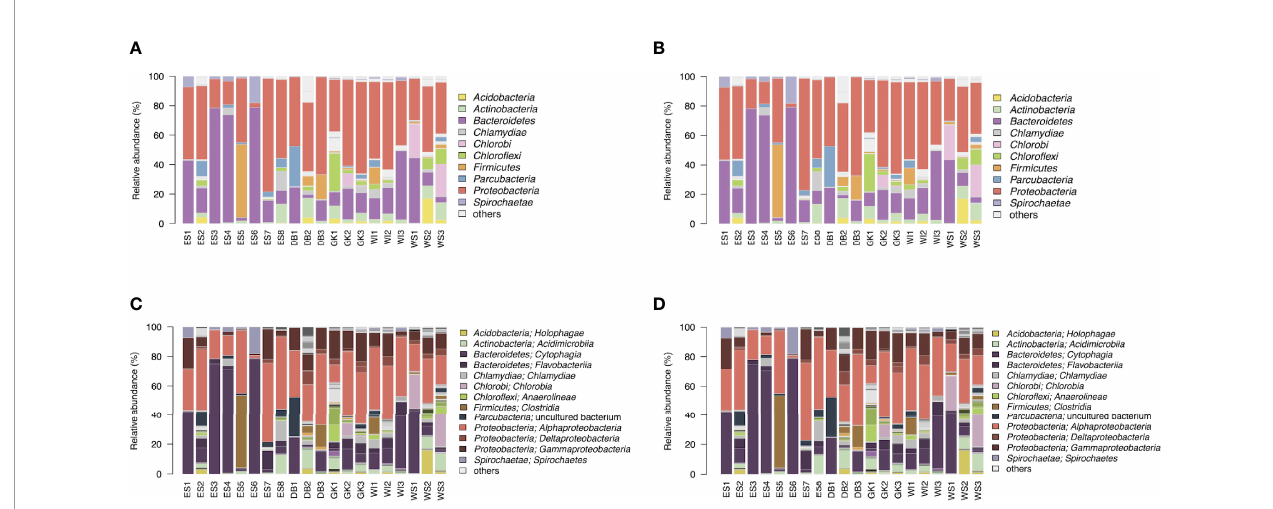
FIGURE 1 | Endolithic bacterial composition in Isopora spp. corals from three locations. (A) and (C) are bacterial phyla and classes, respectively, retrieved by KTU. (B , D) are bacterial phyla and class, respectively, retrieved by ASV. Location acronymous of samples: ES (Dongsha Atoll, Taiwan), DB (Green Island, Taiwan), GK (Green Island, Taiwan), WI (Okinawa, Japan), WS (Okinawa, Japan); please refer the Table 1 to see the detail sampling information.